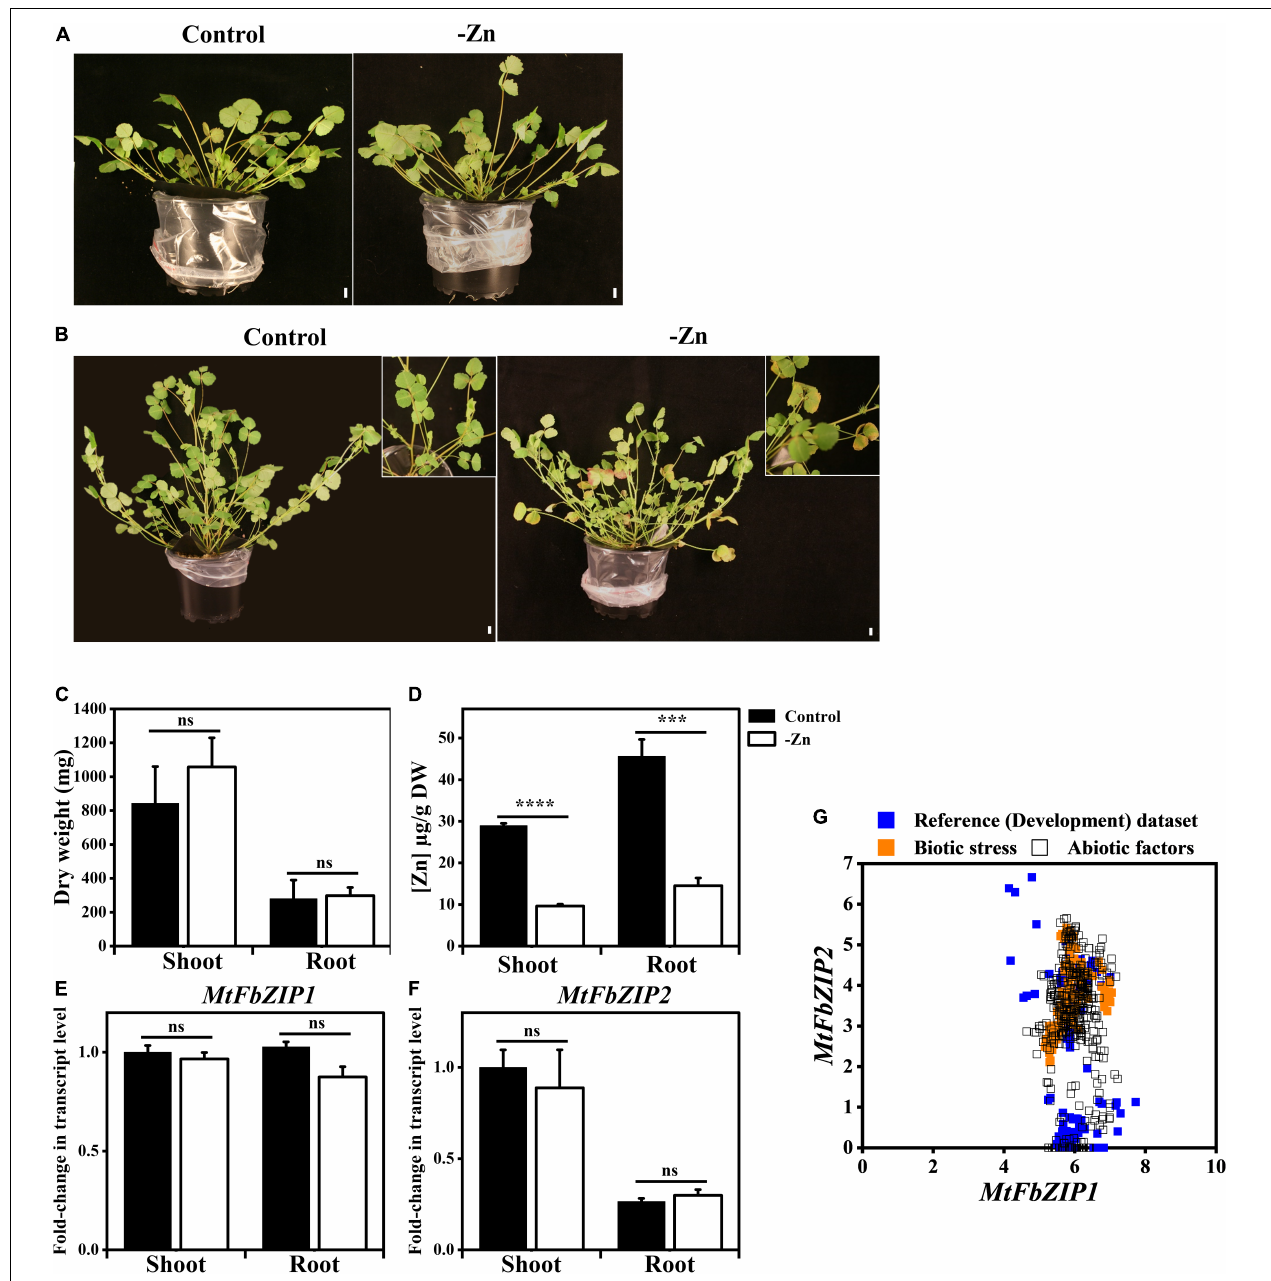
FIGURE 2 | Analysis of M. truncatula plants exposed to Zn deficiency. Phenotypes of (A) 4-week-old and (B) 6-week-old M. truncatula plants grown on sand with nutrient solution at Zn sufficiency (Control) or Zn deficiency (–Zn). Top-right inset in panel (B) shows a detail of plant leaves. Scale bar = 1 cm. Quantification of (C) shoot and root dry weight and (D) shoot and root Zn concentration in 6-week-old plants. (E–G) Expression analysis of M. truncatula F-bZIP genes. Shoot and root transcript levels of (E) MtFbZIP1 and (F) MtFbZIP2 in 4-week-old plants grown at Zn sufficiency (Control) or Zn deficiency (–Zn). Data are represented as means ± SE ( n ≥ 3). Significant differences between Control and –Zn treatments were determined by Student’s t -test (*** p < 0.001, **** p < 0.0001, ns means not significant). (G) Comparative gene expression atlas analysis between MtFbZIP1 (x-axis) and MtFbZIP2 (y-axis) expression values using RNA-seq datasets from M. truncatula MtExpress (https://medicago.toulouse.inrae.fr/MtExpress). Log2/TMM (scale) is used for absolute normalized gene expression values. The different RNA-seq experimental conditions are grouped into three categories: reference (development), abiotic stress and biotic stress dataset ( Supplementary Figure 2